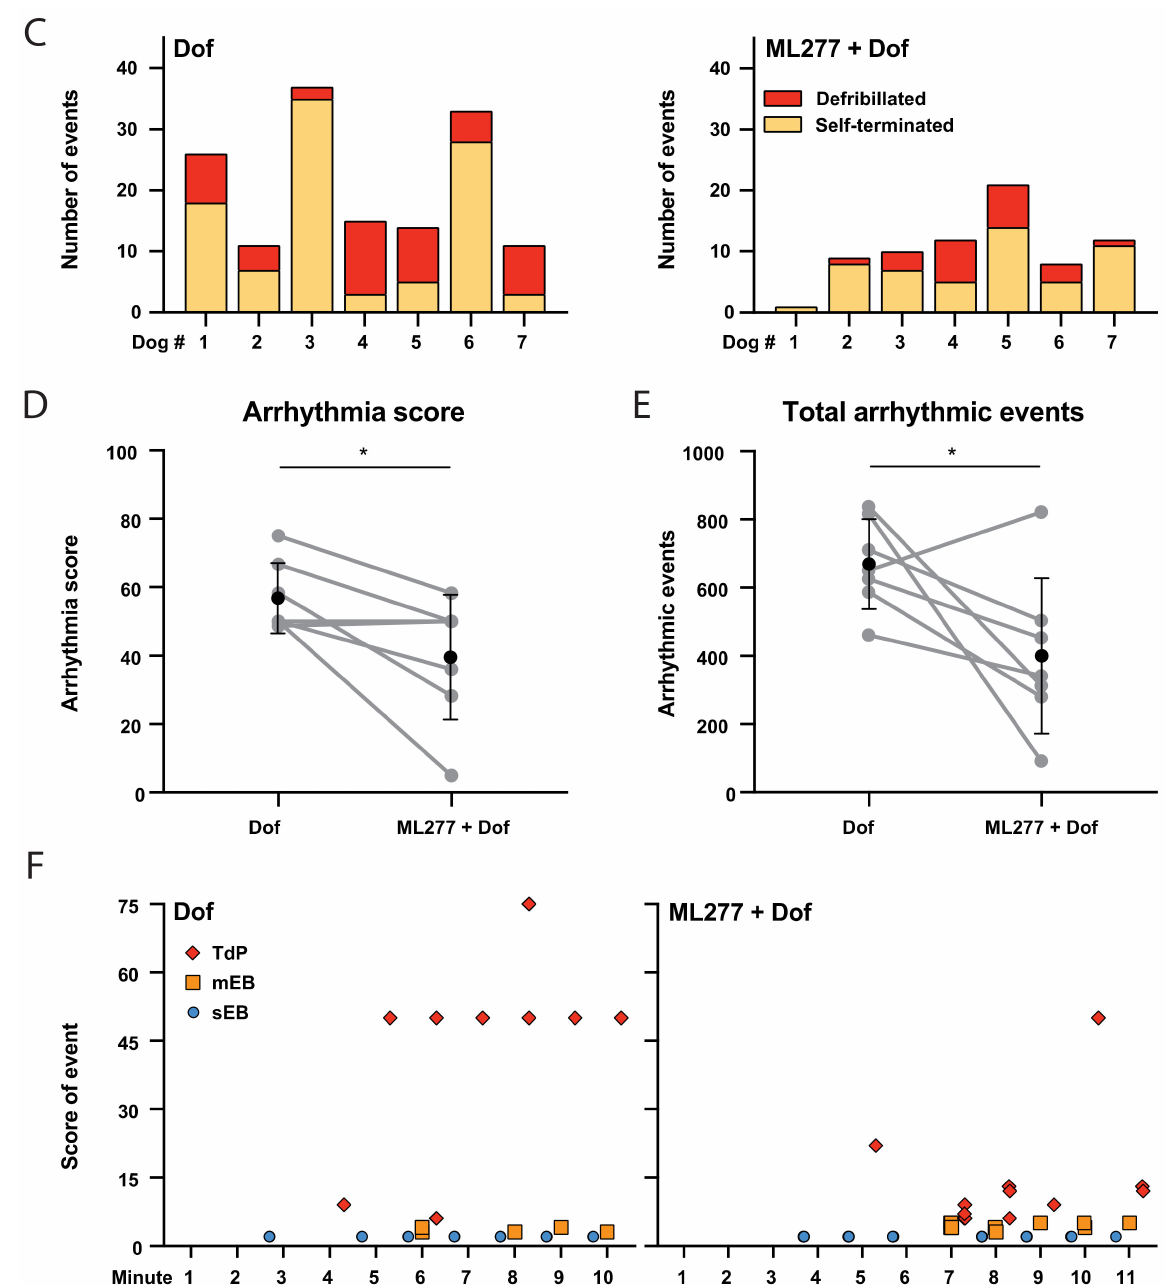
Figure 3. Reduction in Torsade de Pointes (TdP) arrhythmias after ML277. ( A ) Relative TdP score and ( B ) number of TdP arrhythmias terminated by defibrillation during dofetilide (Dof) infusion and during Dof following ML277. ( C ) Overview of defibrillated and self-terminated TdP arrhythmias per dog during Dof and ML277 + Dof. ( D ) Arrhythmia score and ( E ) total of arrhythmic events during Dof and ML277 + Dof. Data of individual dogs in grey and mean ± SD in black, paired t -test with * p < 0.05. ( F ) Representative overview of arrhythmic events in the 10 min time window per minute after the start of Dof (left panel) and after Dof following ML277 (right panel). The score of arrhythmic events refers to single ectopic beats (sEB, 2 points), multiple ectopic beats (mEB, 3–5 points) and TdP arrhythmias (TdP, 6–75 points). A TdP terminated with one shock was scored with 50 points, and two defibrillations were scored with 75 points. A delay of 55 s of the 10 min time window is included in the results of ML277 + Dof. Results are from dog